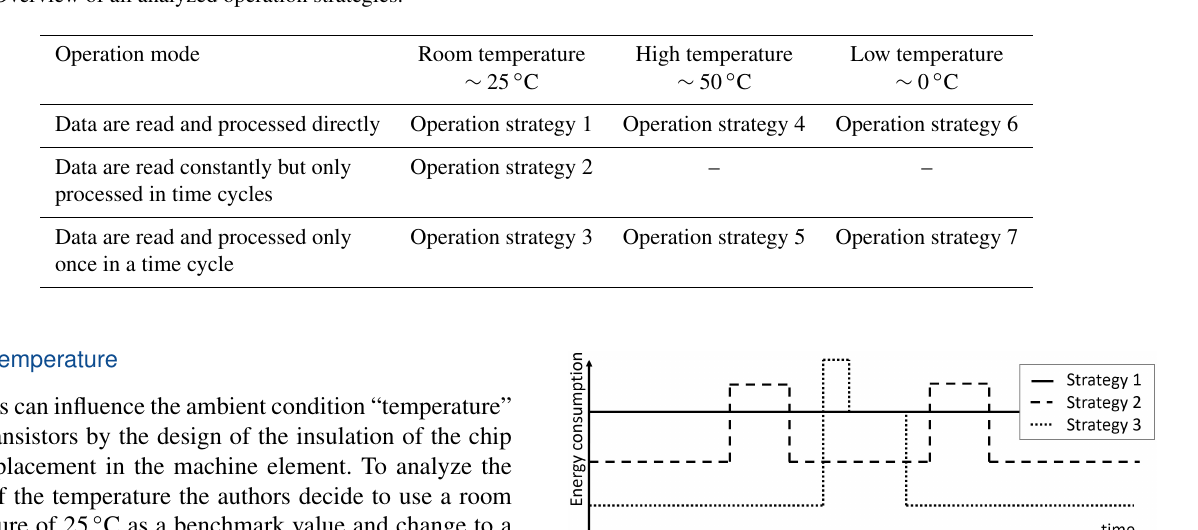
Table 1. Overview of all analyzed operation strategies.